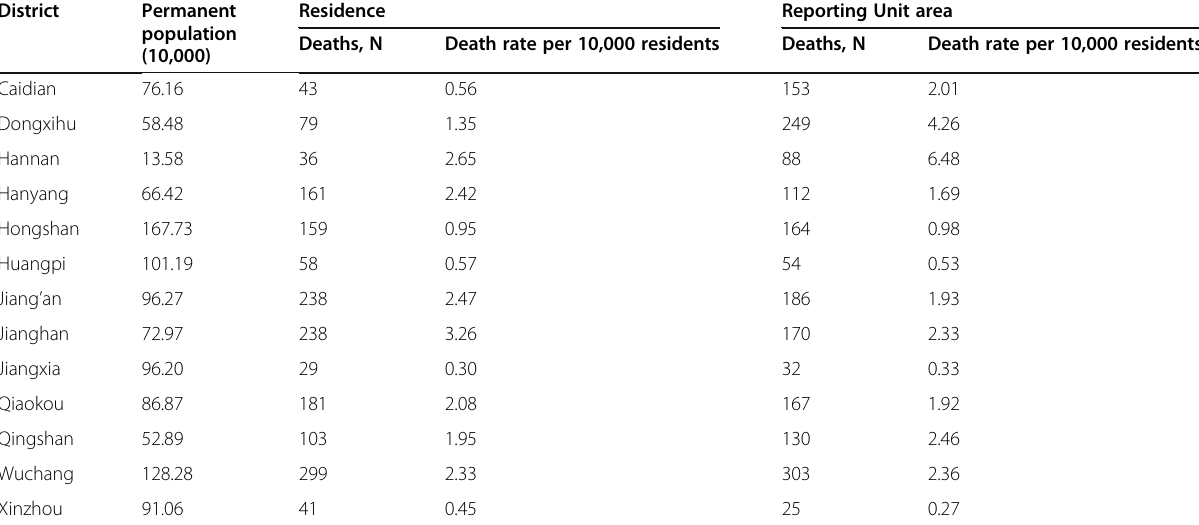
Table 3 Death rate of COVID-19 cases in administrative districts of Wuhan